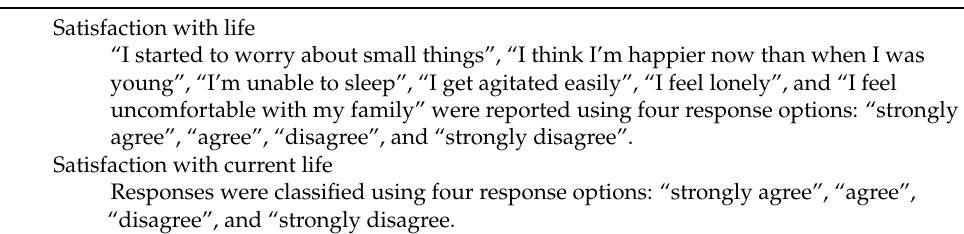
Table 1. Cont. Satisfaction with